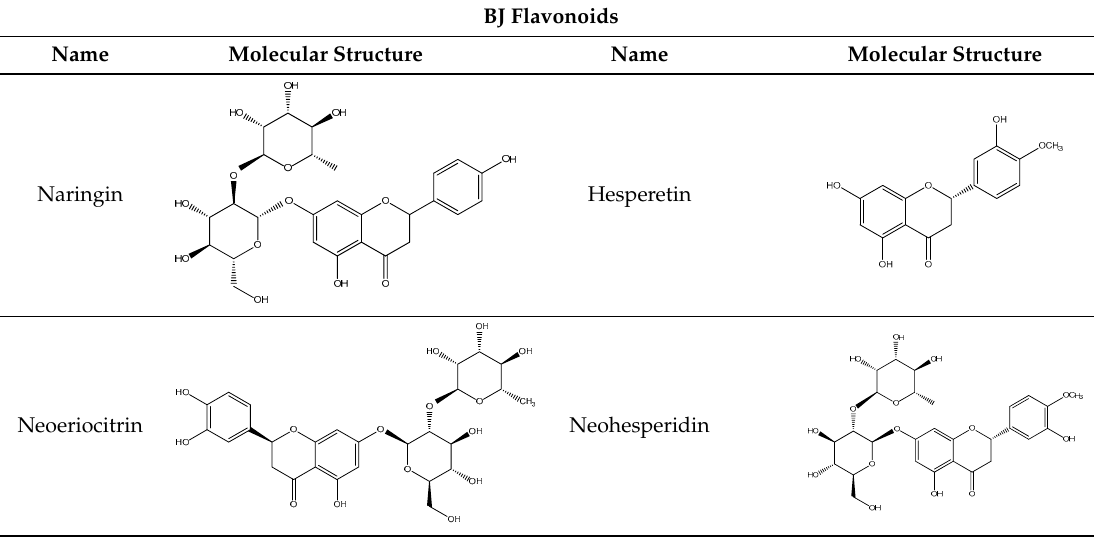
Table 2. The major flavonoids in BJ and their molecular structures.